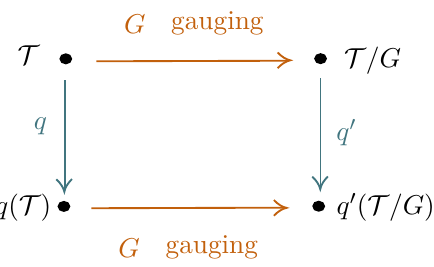
Figure 10 . Galois conjugation of T induces a Galois action on T /G and vice-versa.